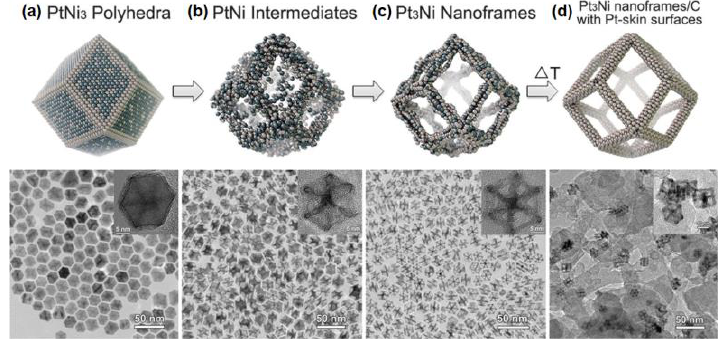
Figure 8. Schematic illustration of the evolution process from polyhedrons to nanoframes: ( a ) initial solid PtNi 3 polyhedrons, ( b ) PtNi intermediates, ( c ) final hollow Pt 3 Ni nanoframes, and ( d ) annealed